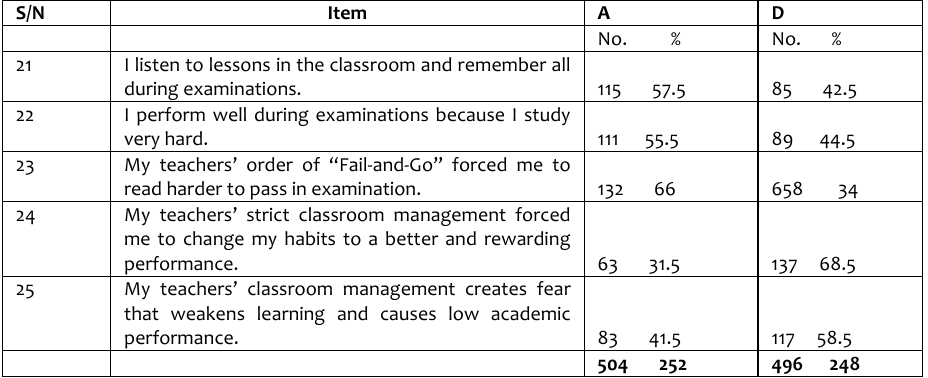
Figure 5 Percentage Presentation of Data for responses on effective classroom management and students’ academic